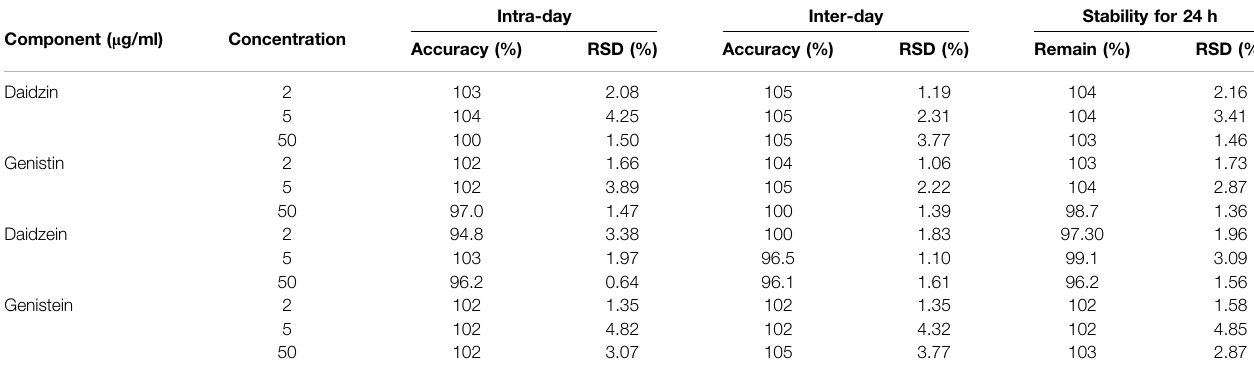
TABLE 2 | Accuracy and precison of intra-day and inter-day and stability for 24 h.